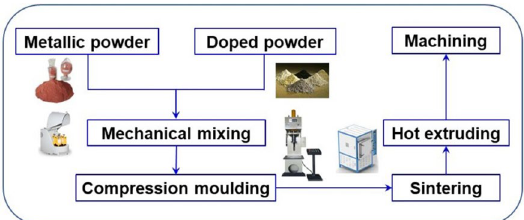
Figure 1. Flow chart of hot-pressing powder sintering process of Cu-based alloys